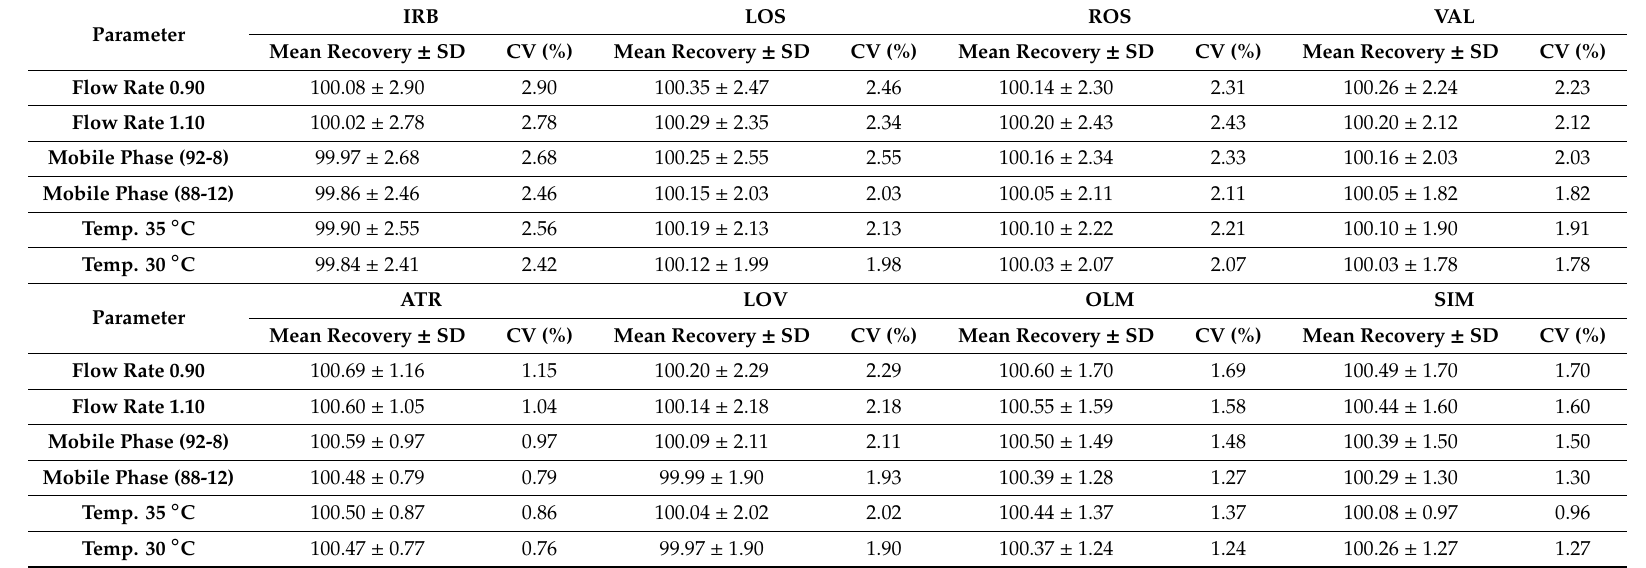
Table 5. Results of the robustness for the determination of irbesartan (IRB), losartan (LOS), rosuvastatin (ROS), valsartan (VAL), atorvastatin (ATR), lovastatin (LOV), olmesartan (OLM), and simvastatin (SIM) (40 mM) using the proposed method.